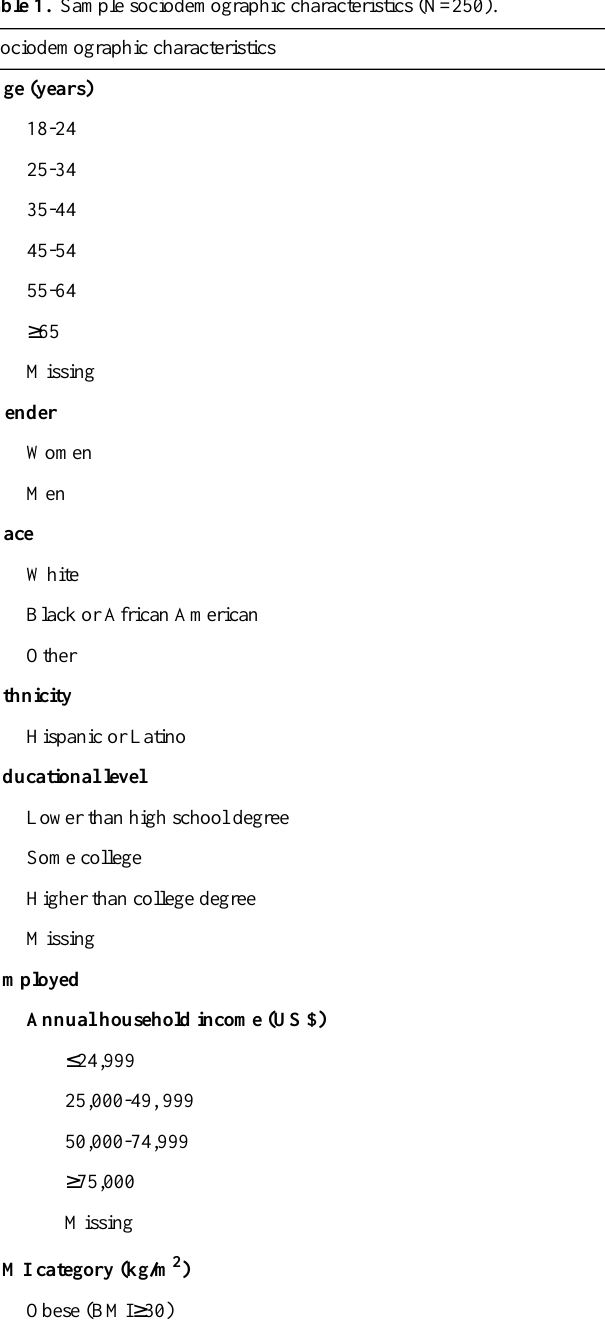
Table 1. Sample sociodemographic characteristics